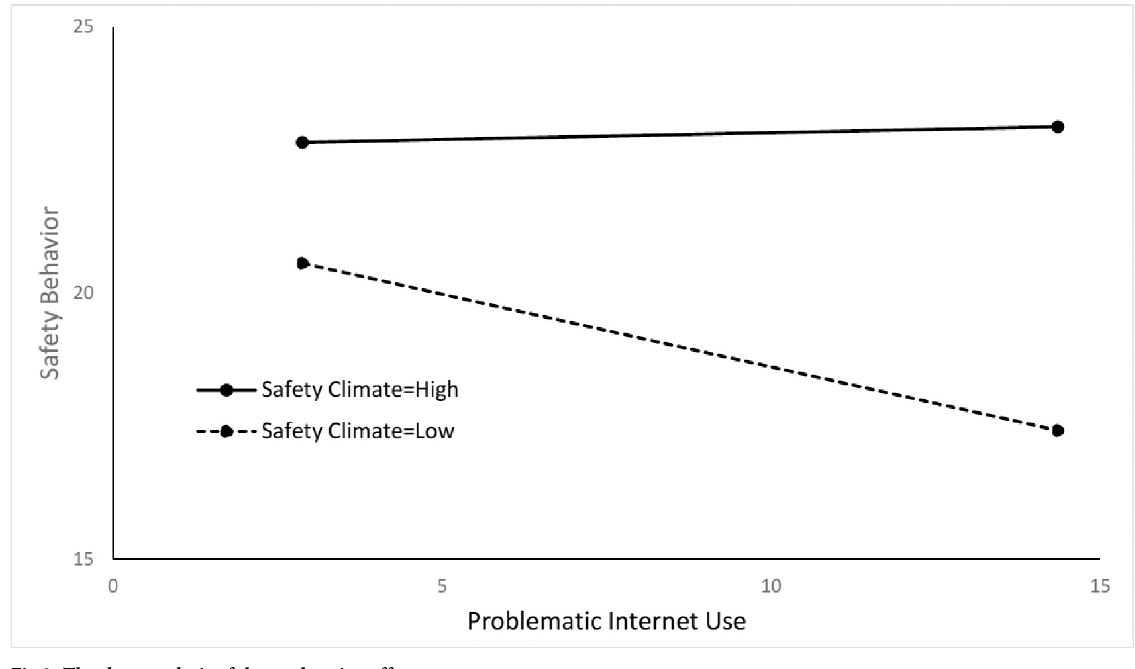
Fig 3. The slope analysis of the moderation